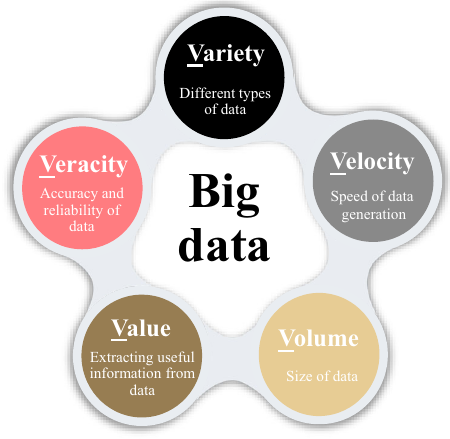
Fig. 6 Five main features of big data. These features, are known as the ‘ Five V ’ s ’ . Big data is described by ‘ Five V ’ s ’ including: Value, Volume (size of data), variety (diversity of data), and veracity (Data accuracy and reliability (, and velocity (speed of the data gathering) 92